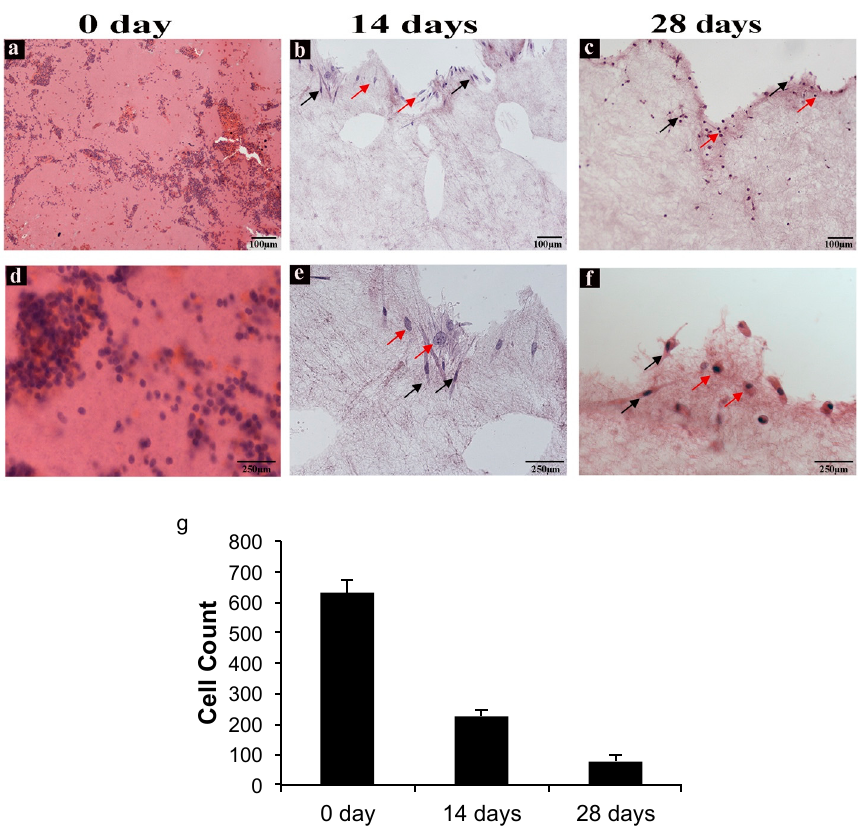
Figure 3. CGF hematoxylin-eosin staining. ( a , d ) Sections of CGF at time zero (0 day), ( b , e ) after 14 days, and ( c , f ) after 28 days of incubation in culture medium. The red arrows indicate the spherical cells, and the black arrows indicate the spindle-shaped cells. ( a – c ) Scale Bar: 100 µ m, ( d – f ) 250 µ m. ( g ) The number of cells in the CGF sections at 0, 14, and 28 days were calculated using ImageJ software. All values were expressed as mean ± SD (n = 3 per group, 3 replicates).